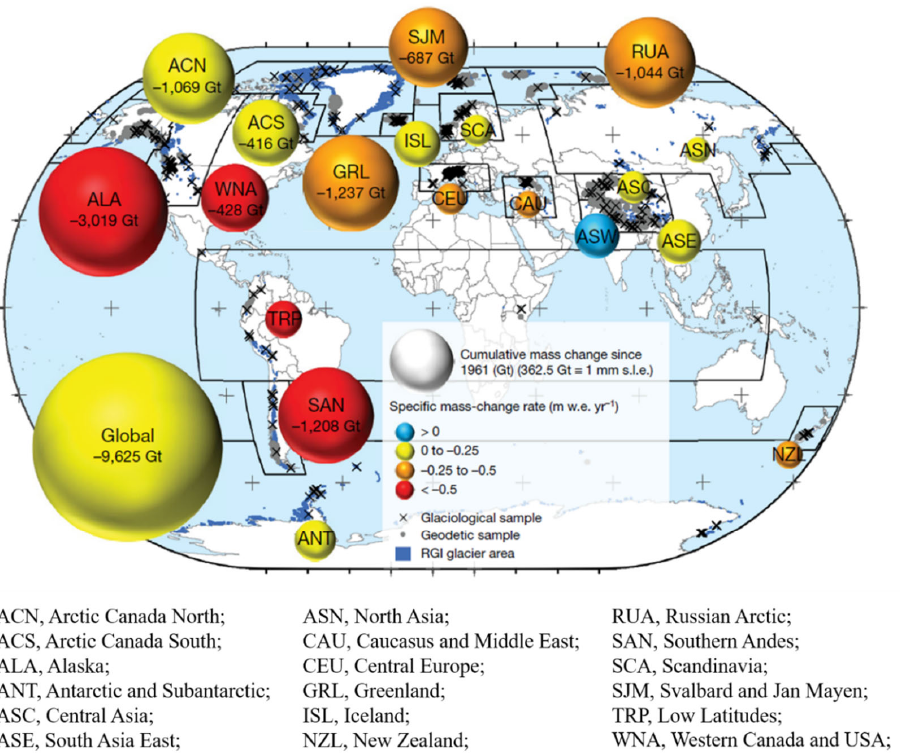
Figure 6. The contribution of glaciers to sea-level rise from 1961 to 2016 (revised from Zemp, Huss [9]).